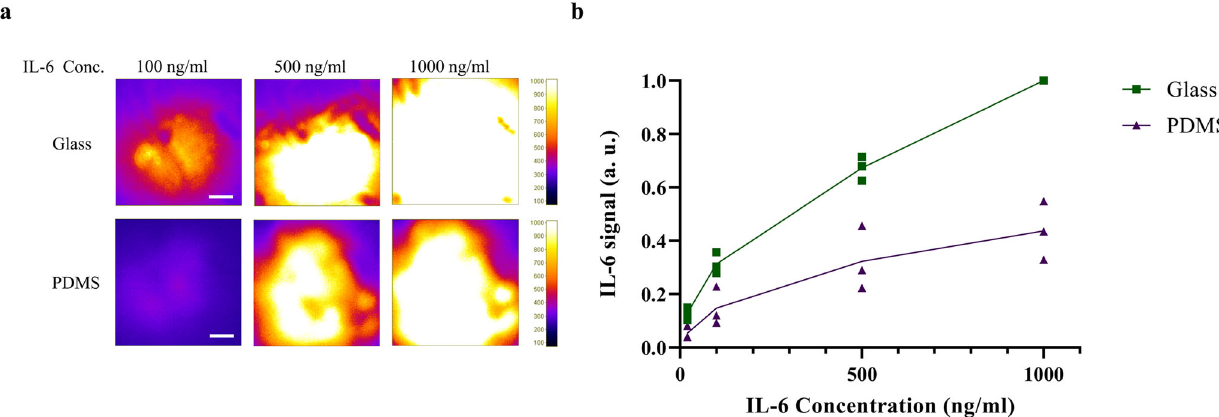
Fig. 3 Standard curve for performance evaluation of the TIR-FM/MSDC biosensor. a Representative images of developed fl uorescence signals obtained after introducing different concentrations of IL-6. An increase in fl uorescence signal was observed after an increase in IL-6 concentration. b The average intensity of the IL-6 quanti fi ed values from a . Glass substrates (green) were more ef fi cient at binding IL-6 compared to PDMS substrates (purple). The results are represented as individual data points in the plots and the solid line denotes the average value. Data were normalized via dividing by the maximum value to bring all the measured values in the dataset to the same metric scale. Independent experiments were performed on three different devices ( n = 3) per substrate. Scale bars represent 10 µ